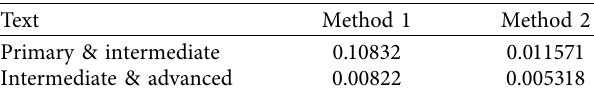
Table 7: KL distances between textbooks of adjacent level.